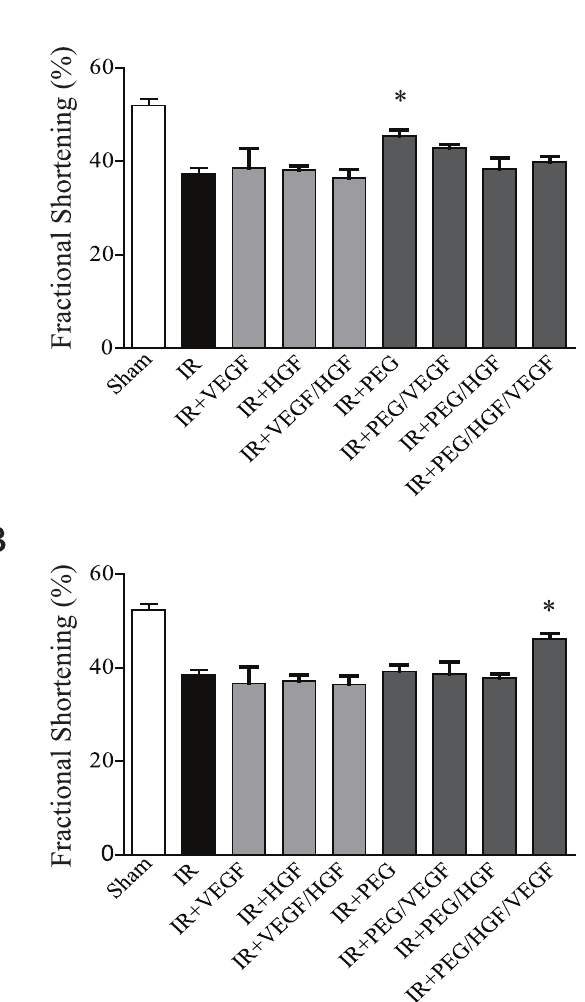
Figure 5. Echocardiographic measurement of function. Grouped data (mean 6 SEM; n $ 7 per group) from A) 7 days post-injury or B) 21 days post-injury. At 7 days there was a significant increase in function only in the empty PEG hydrogel treated rats. At 21 days, only the PEG/ HGF/VEGF rats demonstrated a significant increase in function compared with untreated rats (*p , 0.05; ANOVA followed by Student- Newman-Keuls post-test). PEG=polyethyleneglycol, VEGF=vascular endothelial growth factor, HGF=hepatocyte growth factor, IR=ische- mia reperfusion.